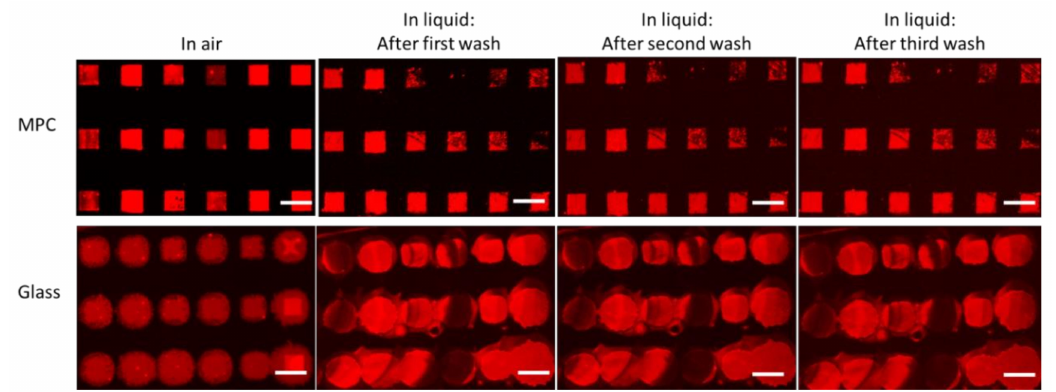
Figure 3. Stability of lipid arrays on block-type MPC copolymer and glass samples. The images show fluorescently labeled lipid patch arrays in air and after three subsequent washing steps on block-type MPC copolymer (top row) and glass (bottom row). The arrays on glass show pronounced spreading on the first washing step. All scale bars equal 50 µ